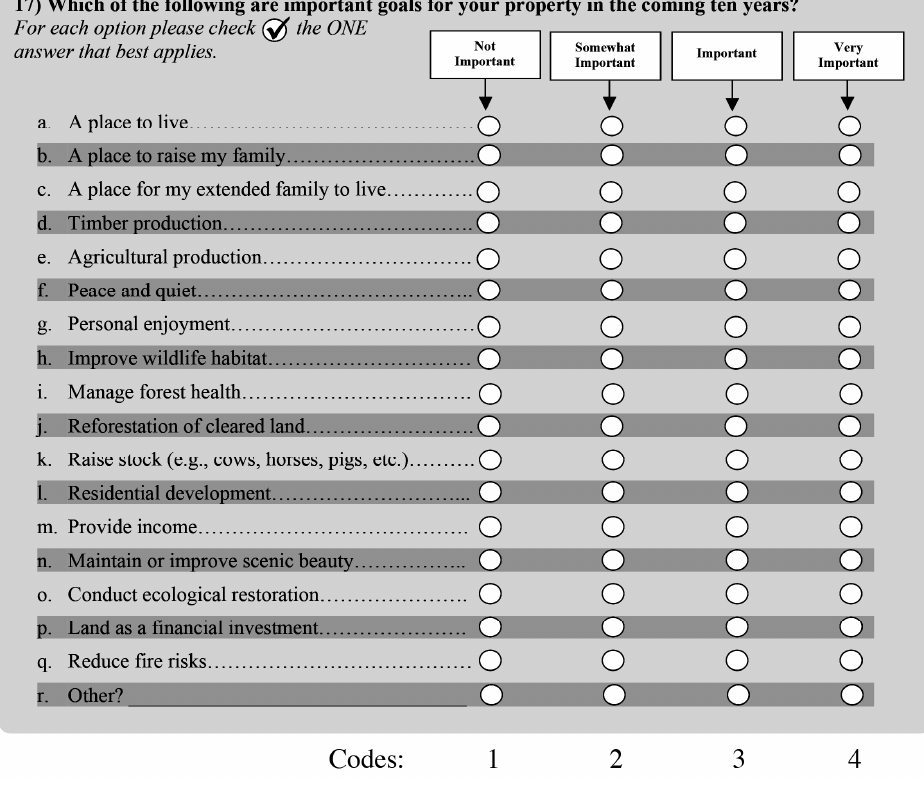
Figure 7. Survey section querying landowners’ motivations for property ownership.